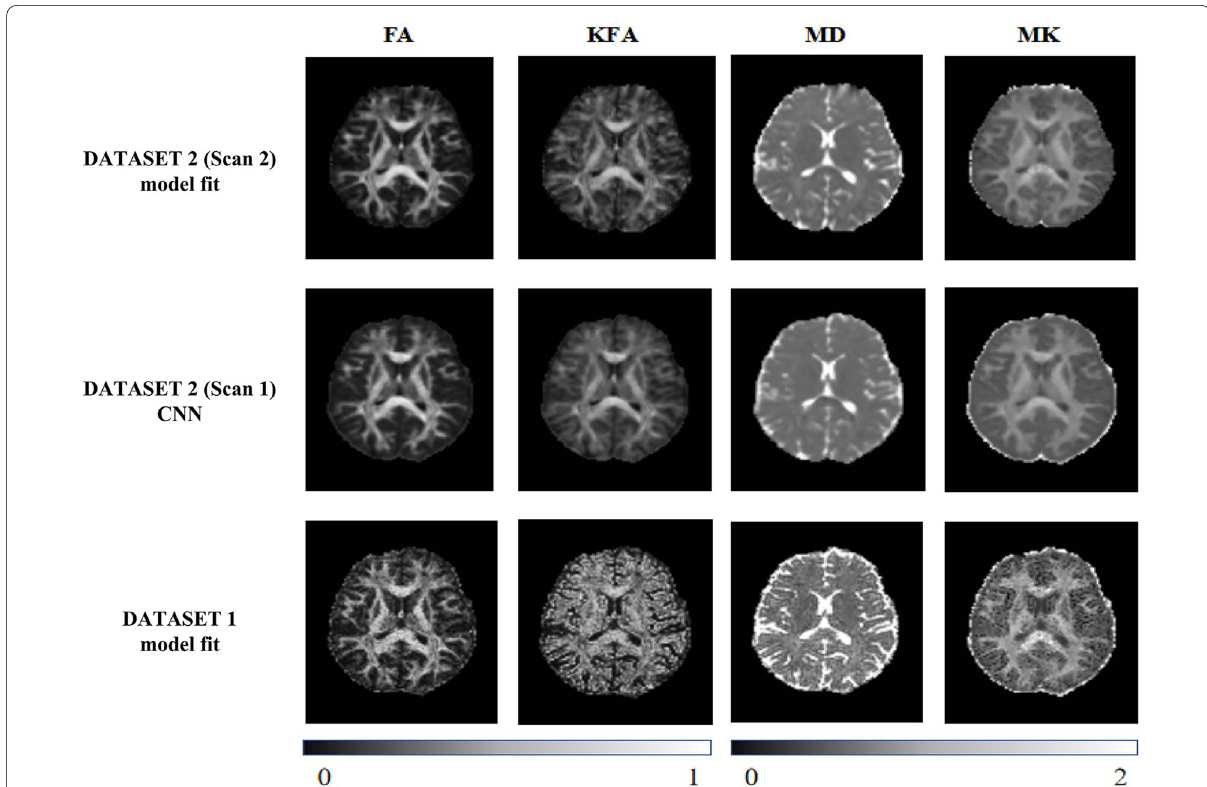
Fig. 1 Maps of diffusion kurtosis imaging scalar measures using different methods. Note. High-quality diffusion kurtosis imaging (DKI) scalar maps with the model-fitting method in the first line, moderate-quality DKI scalar maps with the model-fitting method in last line, and moderate quality of DKI scalar maps with the convolutional neural network (CNN) method in the middle line indicate that the CNN-based method can optimize the scalar maps of moderate diffusion-weighted